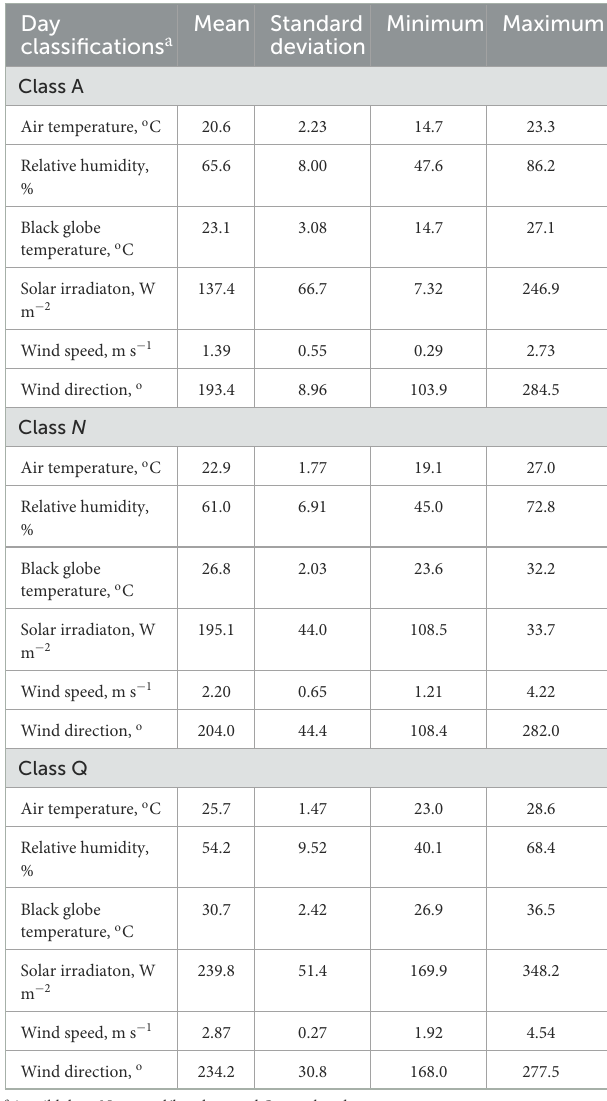
TABLE 5 Meteorological variables of Experiment